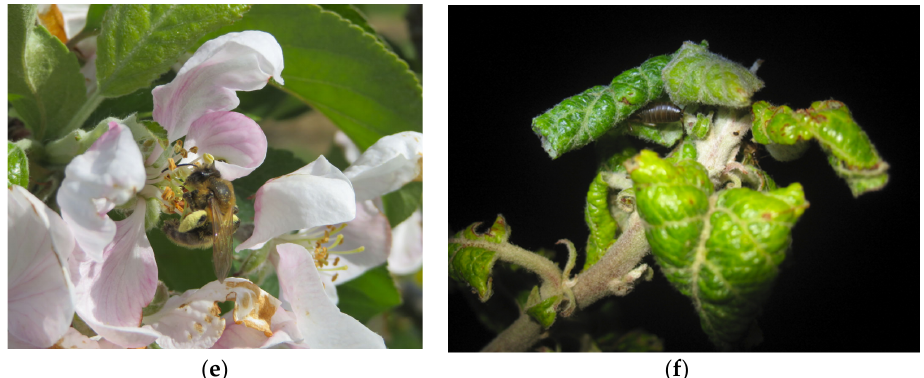
Figure 2. ( a ) Rosy apple aphid colony on an apple (credit NIAB EMR), ( b ) Andrena haemorrhoa , a ground nesting solitary bee, on a dandelion (credit Konstantinos Tsiolis), ( c ) ladybird larva (credit NIAB EMR), ( d ) foliage dwelling spider (credit NIAB EMR), ( e ) solitary bee visiting an apple flower (credit NIAB EMR), and ( f ) European earwig in an apple aphid colony at night (credit Csaba Nagy). In a six ‐ year study of pests and natural enemies in apple orchards, Markó et al. [49] found no additional control of pests in alleyway sowings of perennial flowering herbs, although the abundance and diversity of predatory phytoseiid mites increased with the flowering ground cover in spring and autumn. In addition, Typhlodromus pyri gradually displaced Amblyseius andersoni in the presence of flowers. Although lacewing, parasitoid wasps, and spider numbers were higher in flower ‐ sown orchards compared to control orchards, no significant increase in pest control was observed at this time [68,69]. Markó et al. [49] also pointed out the impact of several highly active insecticides disguising any